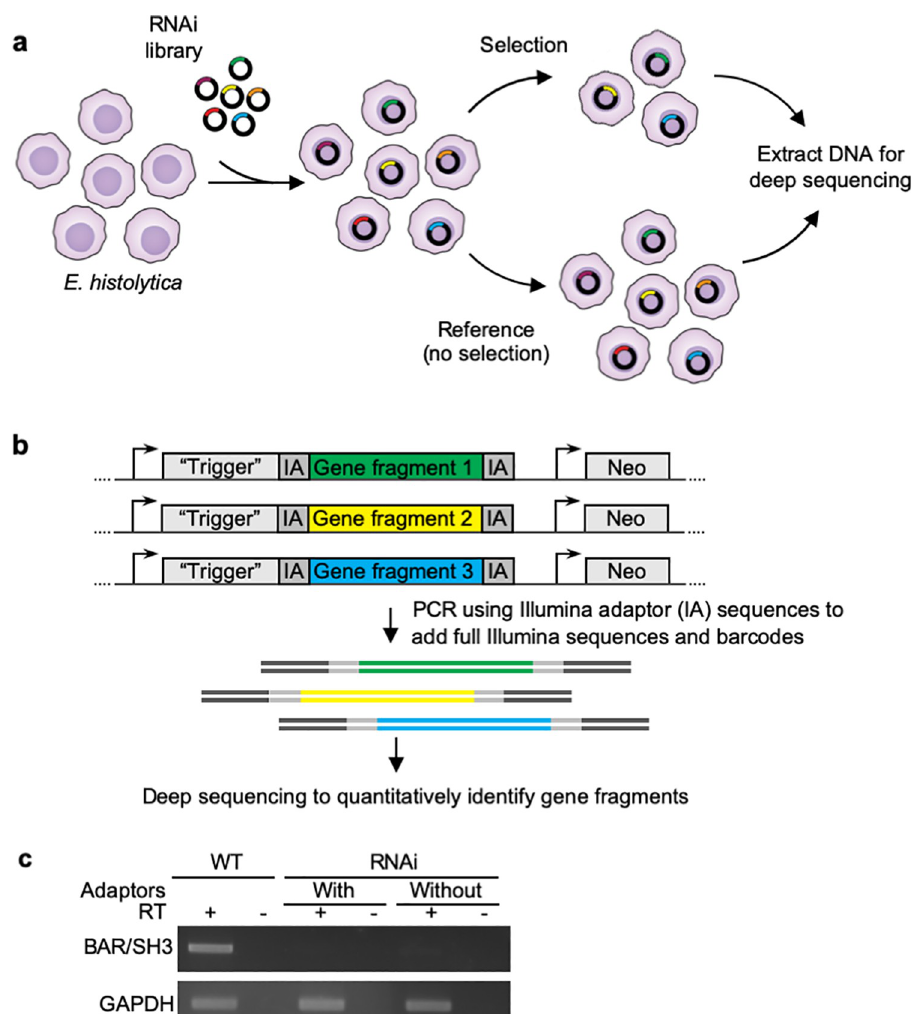
Fig 1. RNAi library strategy. a, The plasmid RNAi library contains random fragments of gDNA cloned into the trigger RNAi plasmid (pTriggerAdaptor). Different plasmid inserts are represented by different colors in this schematic. A heterogeneous population of stably transfected RNAi knockdown mutants can be exposed to selection or screening. To identify gene fragments that are represented in the population after selection/screening, gDNA is extracted for analysis. gDNA extracted from non-selected amoebae is used as a control. b, Schematic representation of the plasmid RNAi library. pTriggerAdaptor is shown, with different inserts represented by different colors. The “trigger” is a 132 bp fragment of EHI_048600. pTrigger was modified to create pTriggerAdaptor, containing custom Illumina TruSeq adaptor sequences (IA) upstream and downstream of the cloning site to facilitate amplicon sequencing. A single round of PCR is needed to add the remaining Illumina sequences (shown in dark gray) and barcodes necessary for Illumina deep sequencing analysis. c, An 812 bp fragment of a BAR/SH3 domain-containing protein (EHI_091530) was inserted into pTrigger with or without custom Illumina TruSeq adaptors flanking the cloning site. The BAR/SH3 domain-containing protein was in the forward orientation and in frame relative to the trigger sequence. Stably transfected heterogeneous mutants were assessed for knockdown of the targeted gene using RT-PCR, with (+) or without (-) reverse transcriptase. GAPDH (EHI_187020) was used as a loading control.